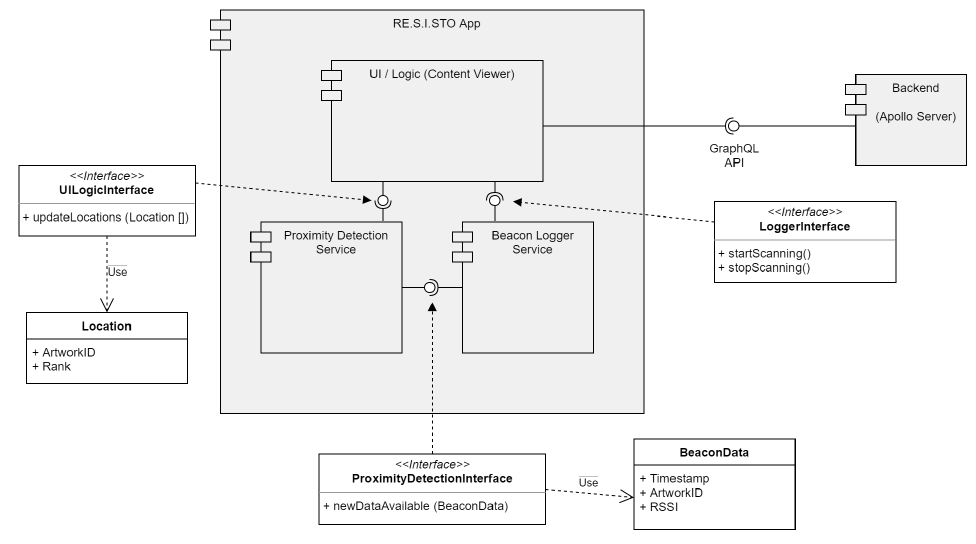
Figure 1. Design of the RE.S.I.STO